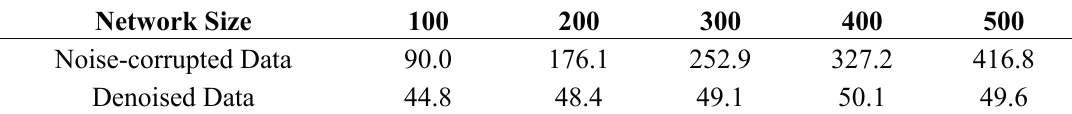
Table 3. The impact of the network size on the noise level.